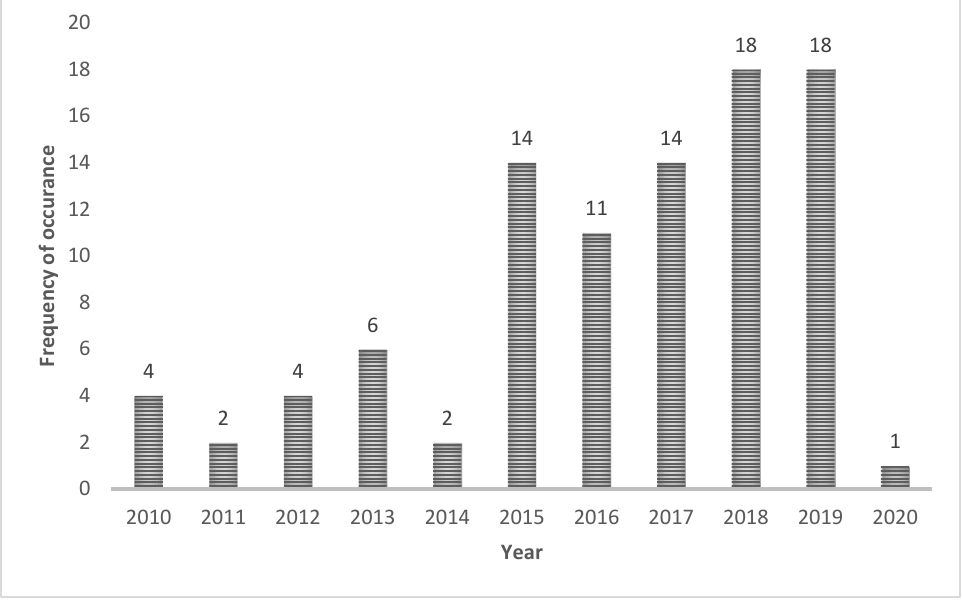
Figure 4. Number of papers by location where the study took place.